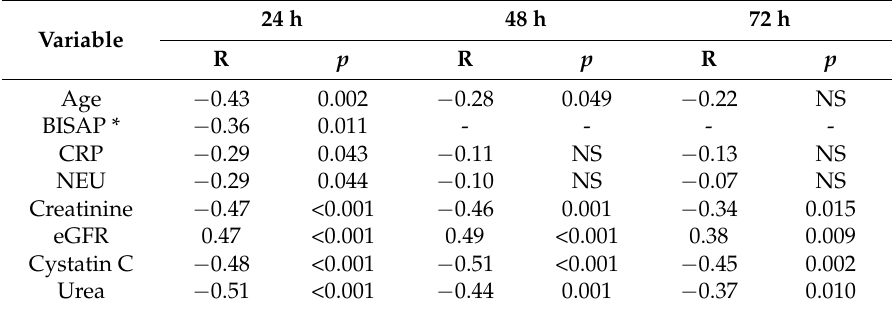
Table 2. Correlations between serum uromodulin concentrations and the selected variables (including the biomarkers of renal function) during the first 72 h of acute pancreatitis.